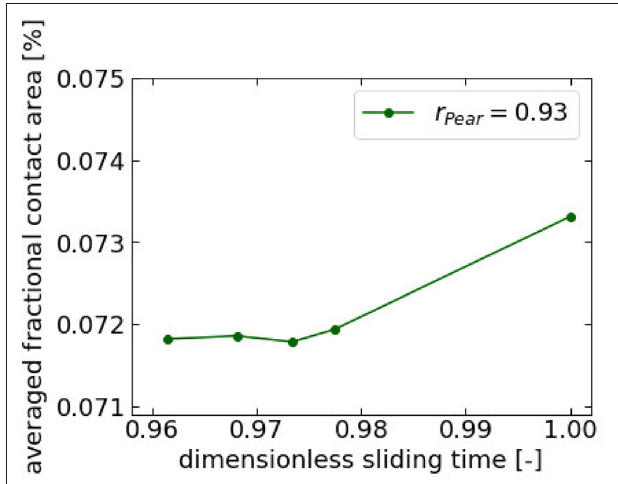
FIGURE 8 | Average fractional contact area as a function of dimensionless sliding time. The fractional area of contact A fr ( D ) is averaged using the normalized grain size distribution f ( D ). This yields h A fr i ; see Equation (13). The inset shows the corresponding Pearson correlation coefficient. Note, the similarity to Figure 6A